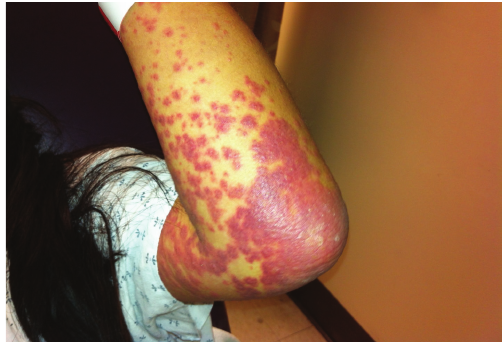
Figure 2: Left ventral arm/elbow: discrete and coalescing, non- blanching papules coalescing into plaques, most consistent with a palpable purpura.